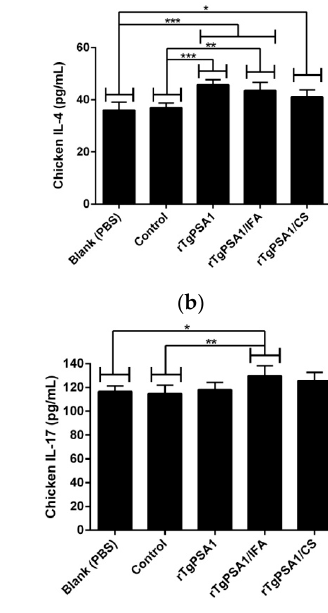
Figure 8. Total IgY antibody calculation in sera of chickens immunized at two, four, and six weeks of age. Each sample was conducted once. Values were assessed using one-way ANOVA followed by Dunnett’s test, and are shown as means of OD450 ± SD (n = 5). Values between rTgPSA1/IFA and rTgPSA1/CS groups were compared with the independent t -test. ** p < 0.01 and *** p < 0.001 compared with blank or control group.